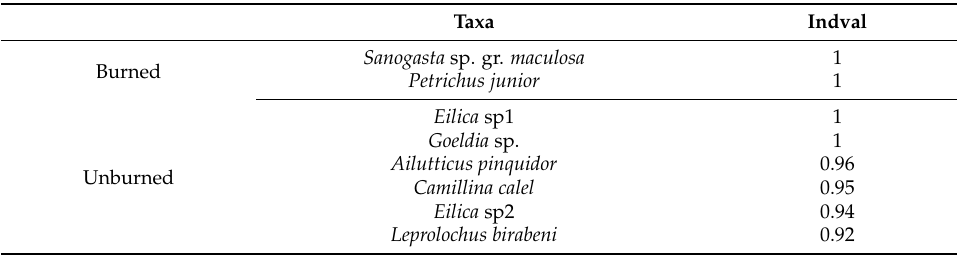
Table 2. Taxa indicators of burned or unburned sites. Only species/morphospecies with statistically